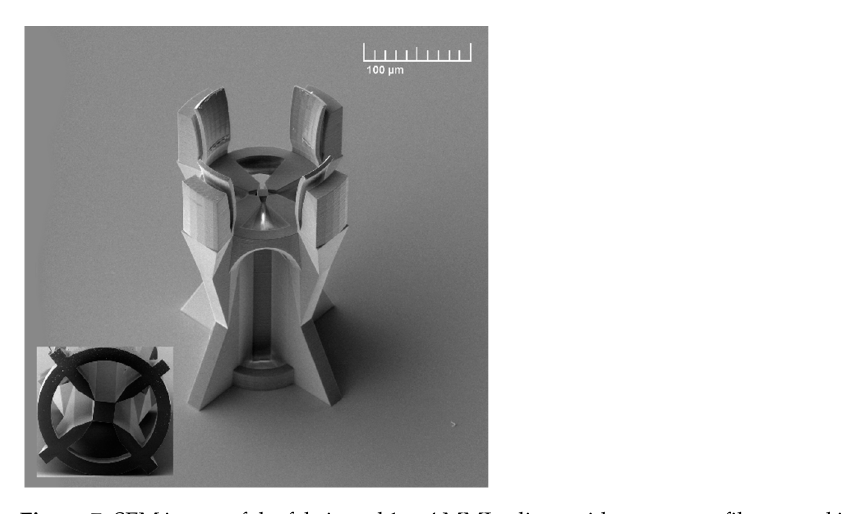
Both splitters were fabricated and characterized to validate the simulation results.